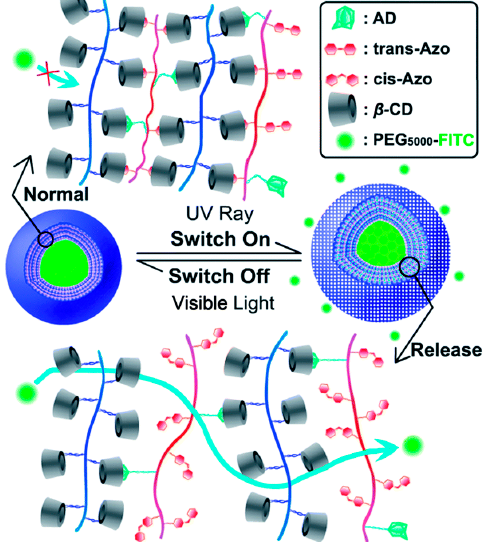
Figure 7. On/off photo-responsive switch in the LbL microcapsules designed by Lin et al. [63]. Reprinted with permission from [63]. Copyright 2014 Royal Society of Chemistry.